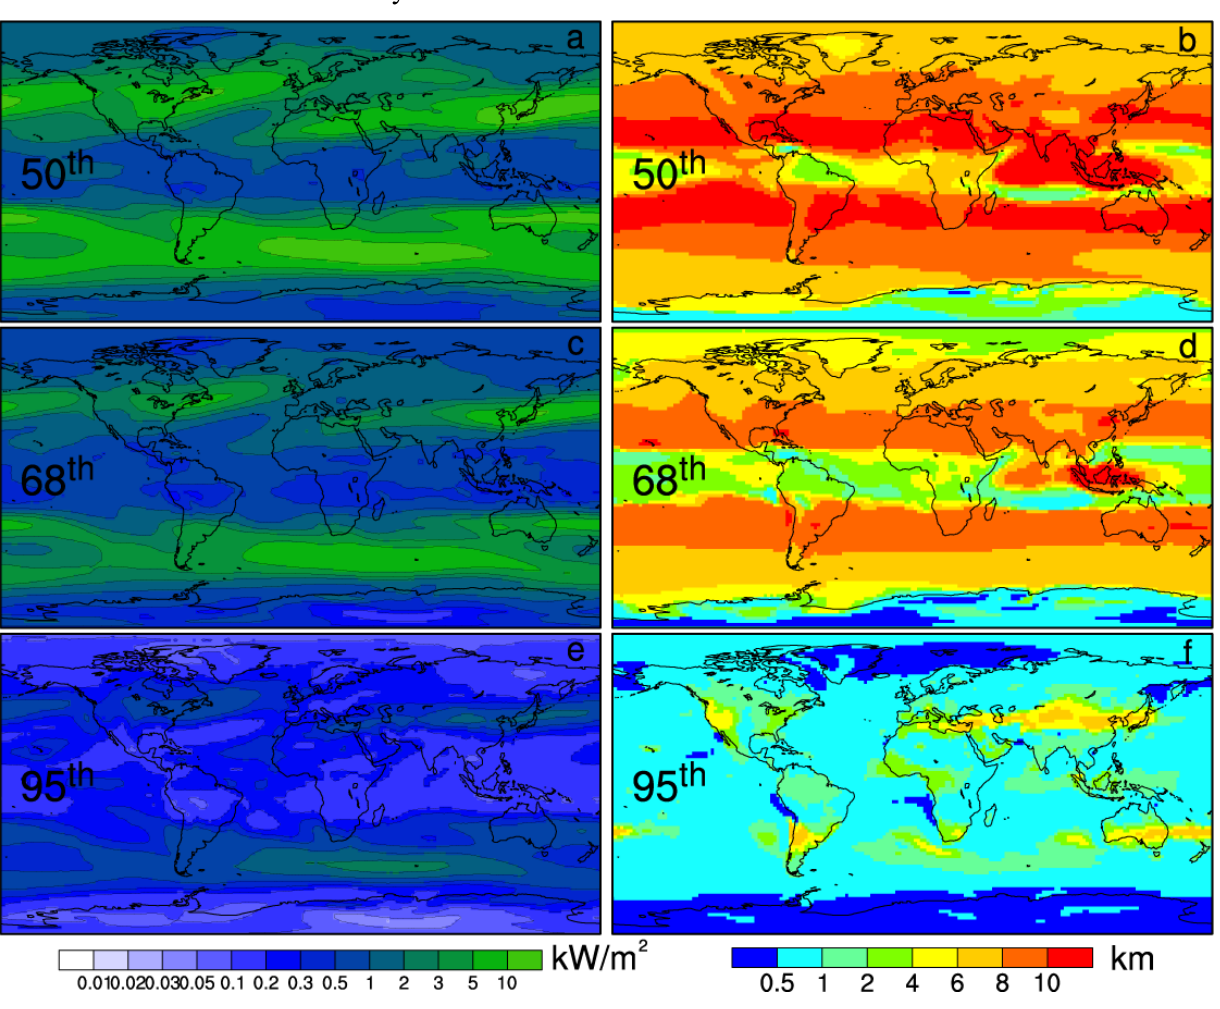
Figure 4. Optimal wind power density (kW/m 2 , left panels) and optimal height (km, right panels) that was exceeded 50%, 68%, and 95% of the times during years in 1979-2006 from the NCEP/DOE